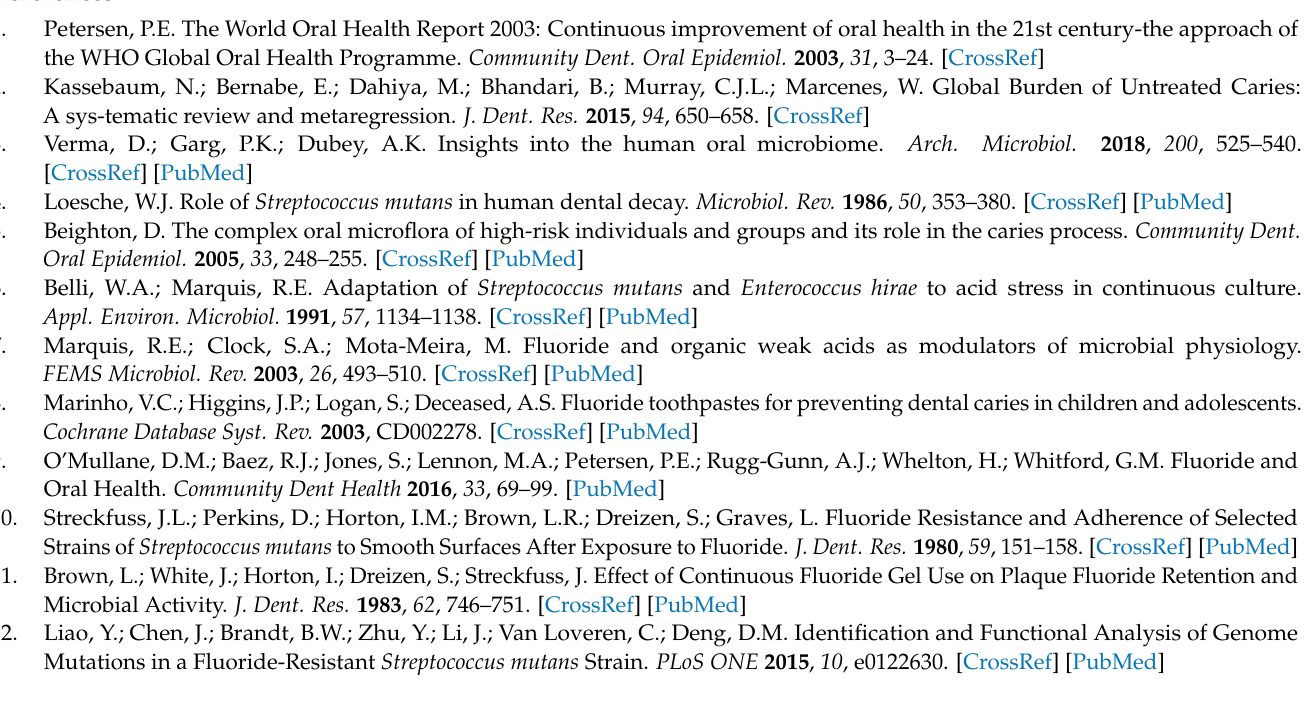
regulated genes in the FR strain; Table S3: Down-regulated genes in the FR strain, Figure S1: Genetic competence; Figure S2: Growth behaviors of S. mutans wild-type and mutant strains obtained during growth in BHI